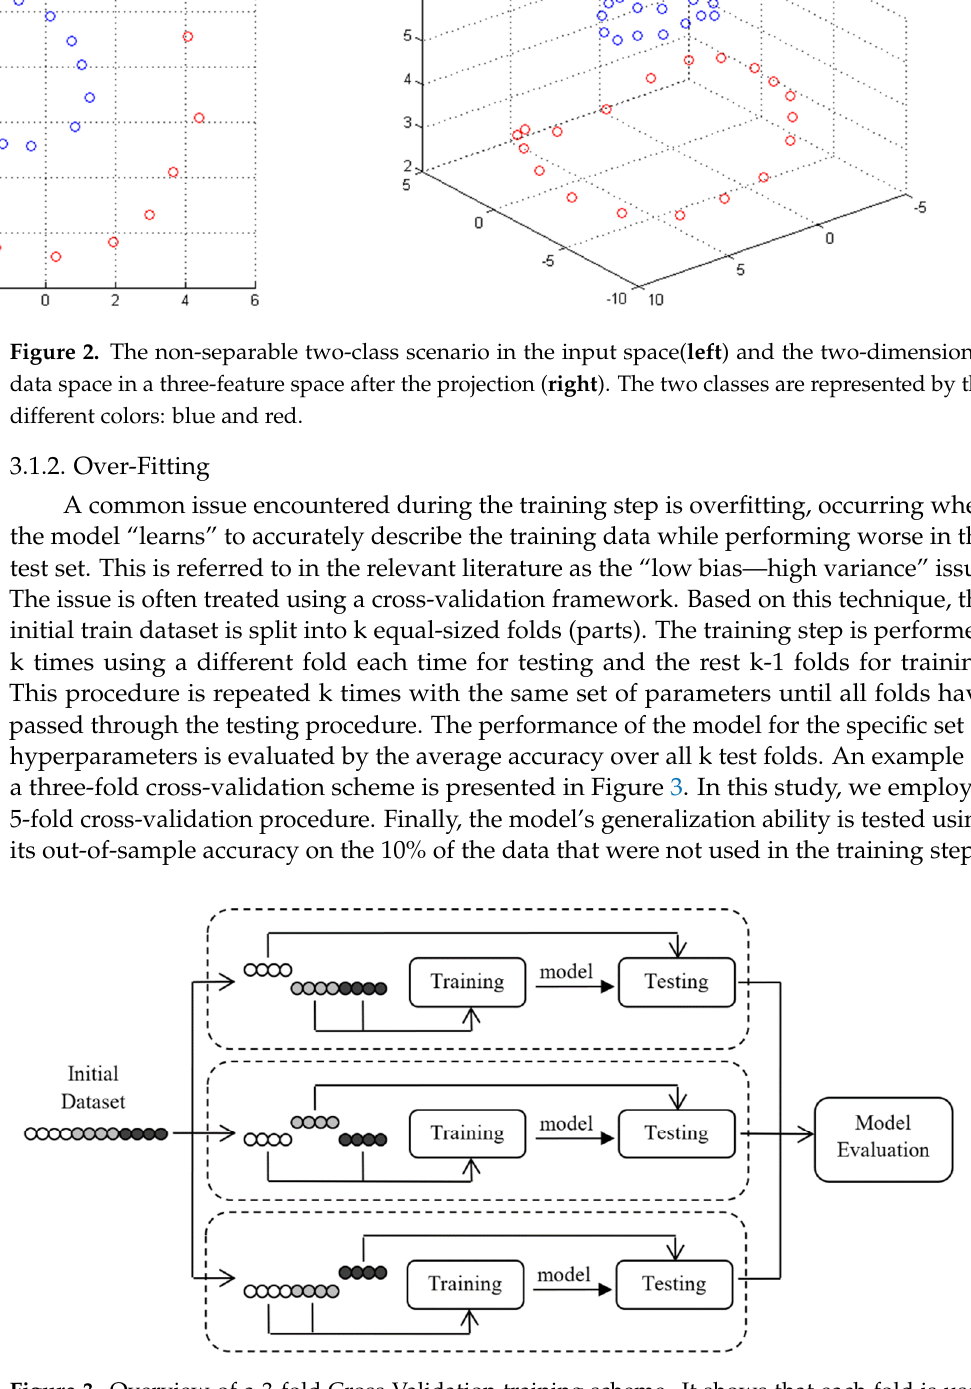
Figure 3. Overview of a 3-fold Cross Validation training scheme. It shows that each fold is used as a testing sample, while the remaining folds are used for training the model for each parameters’ value combination.